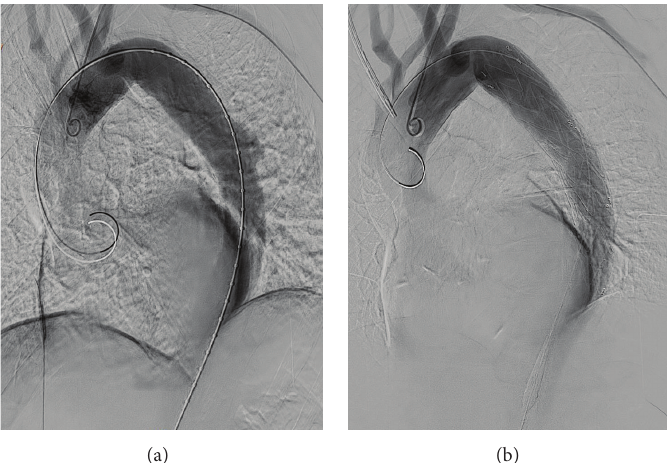
Figure 3: Image of angiographic findings taken during operative treatment. (a) Angiographic findings before treatment. The origin of the right subclavian artery was confirmed, and ULP was observed on contrast-enhanced CT. (b) Angiographic contrast-enhanced CT findings after placement of the stent grafts. The stent grafts were inserted so that the tips did not come into contact with the curve of the arch. The disappearance of the ULP was confirmed by contrast-enhanced CT.